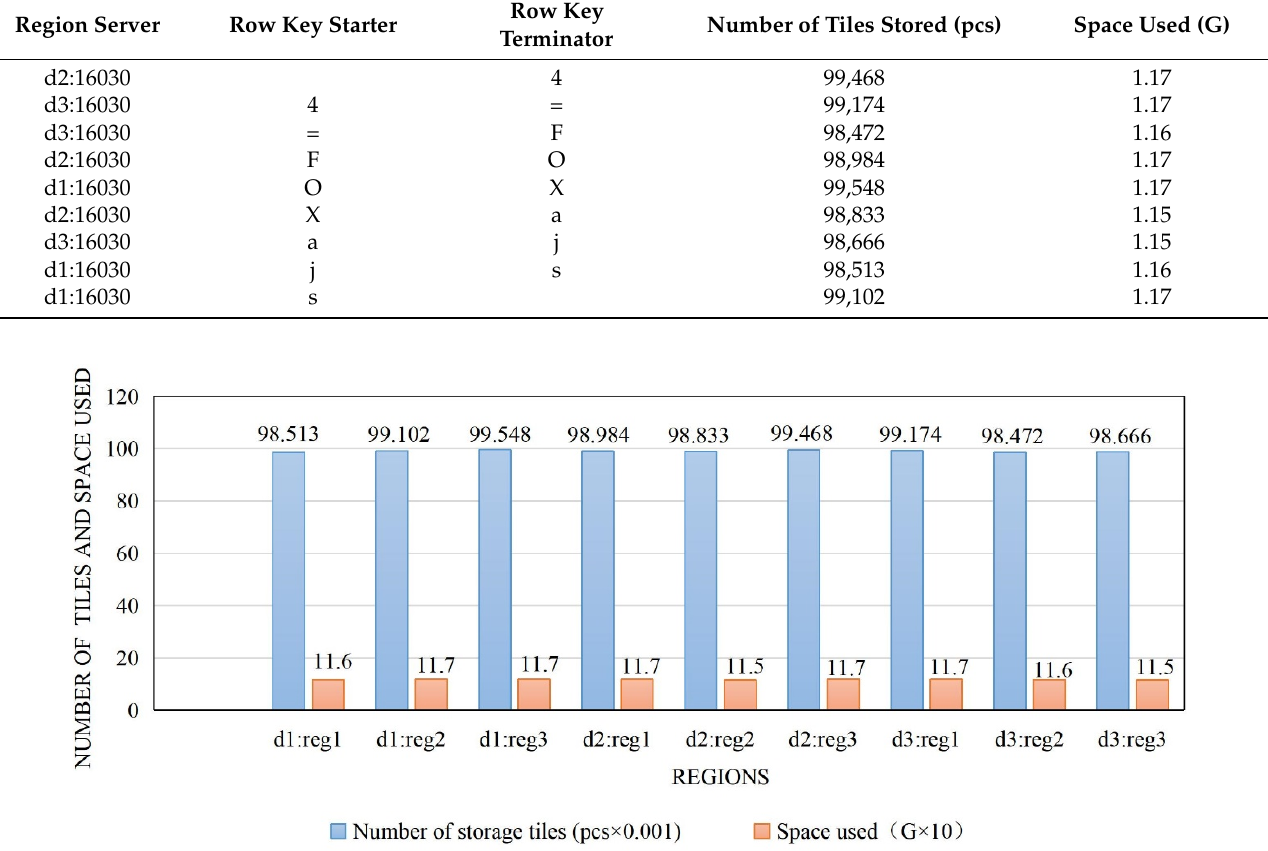
Table 2. Distribution of tile data on region servers.